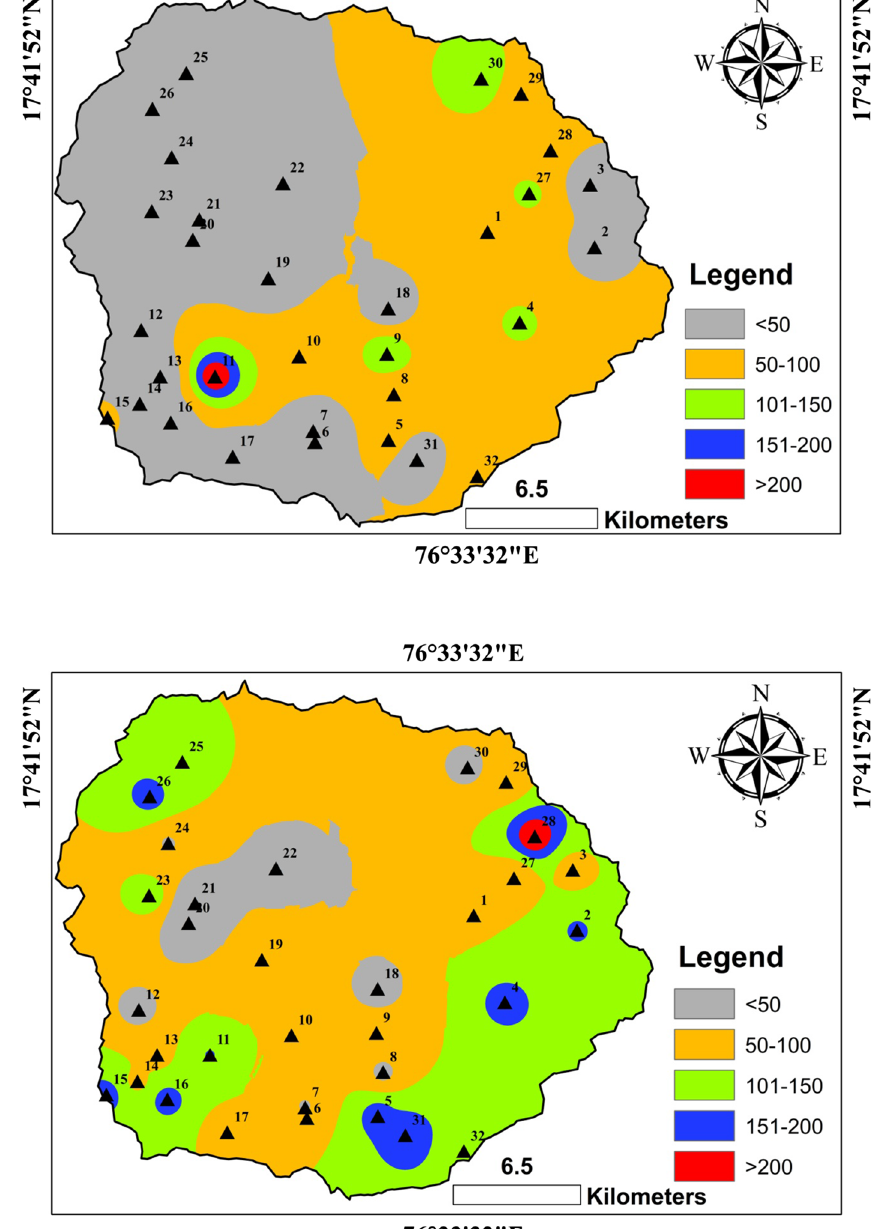
Fig. 8 Geospatial distribution of calcium (pre-monsoon)